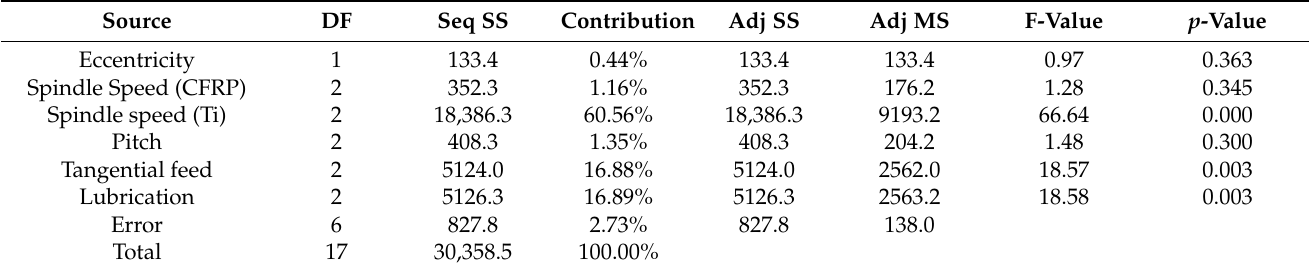
Table 11. Analysis of variance of cutting-edge peripheral wear.